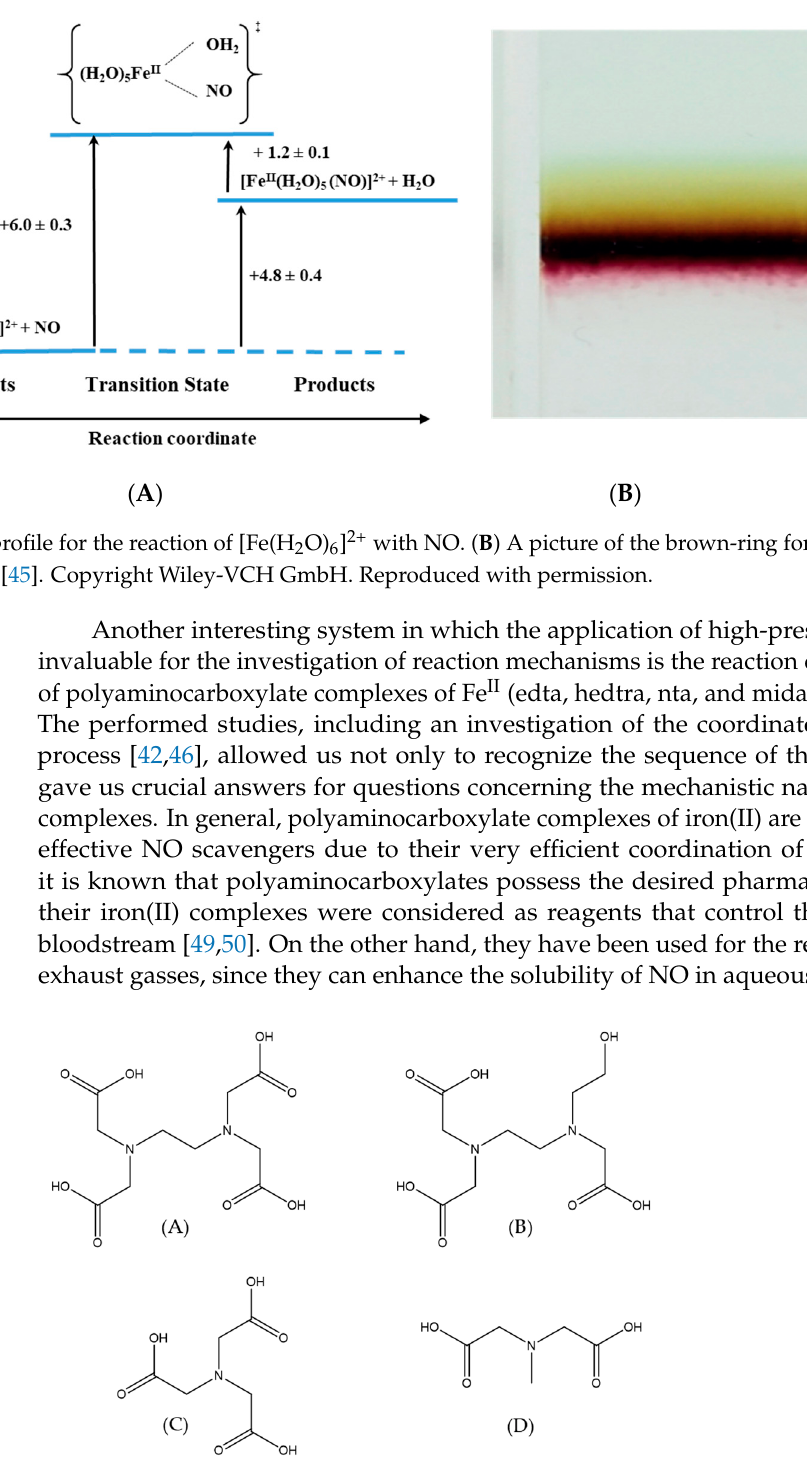
Figure 16. Structures of the ligands: ( A ) edta (ethylenediaminetetraacetate), ( B ) hedtra (hydroxyethylenediaminetriacetate), ( C ) nta (nitrilotriacetate), and ( D ) mida (methyliminodiacetate).